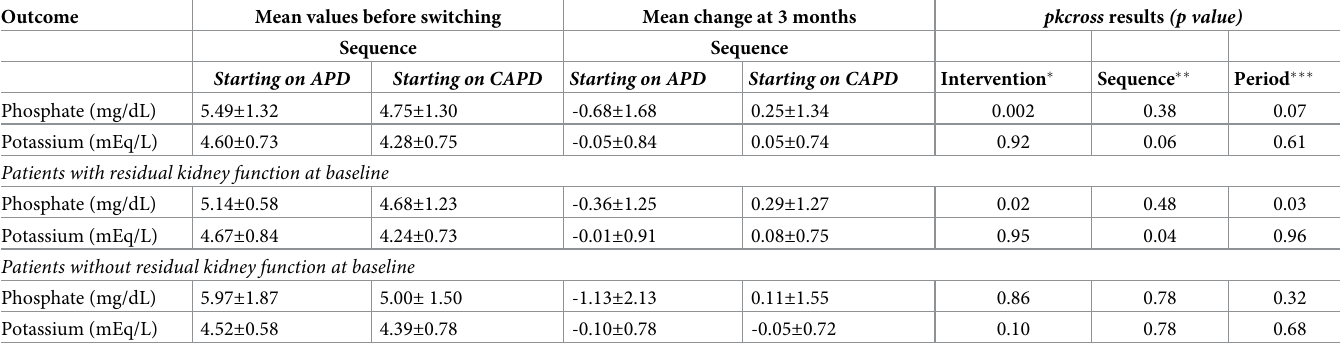
Table 2. Impacts of PD modality switch on serum phosphate and potassium levels.